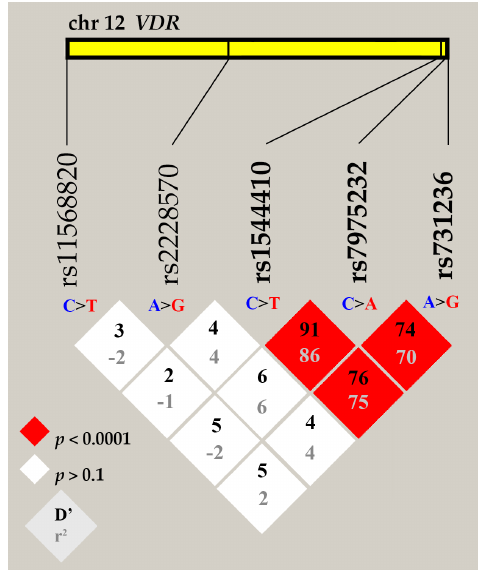
Figure 1. Linkage disequilibrium (LD) plot for rs7975232, rs1544410, rs731236, rs2228570, and rs11568820 variants of the VDR gene. LD is displayed as pairwise D’ values multiplied by 100 and given for each SNV combination within each cell. Red cells correspond to a very strong LD; rs7975232, rs1544410, and rs731236 variants are in the same LD block.